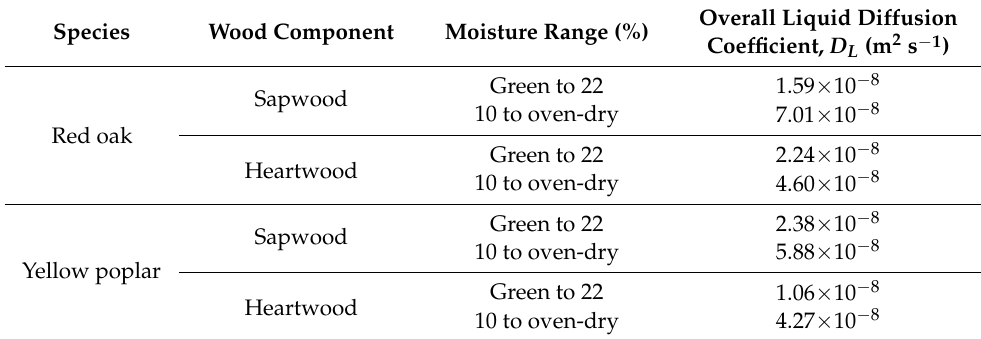
Table 4. Average overall liquid diffusion coefficients ( n = 2) for sapwood and heartwood of red oak and yellow-poplar in the moisture range of 0 and 76 during isothermal drying at 105 ◦